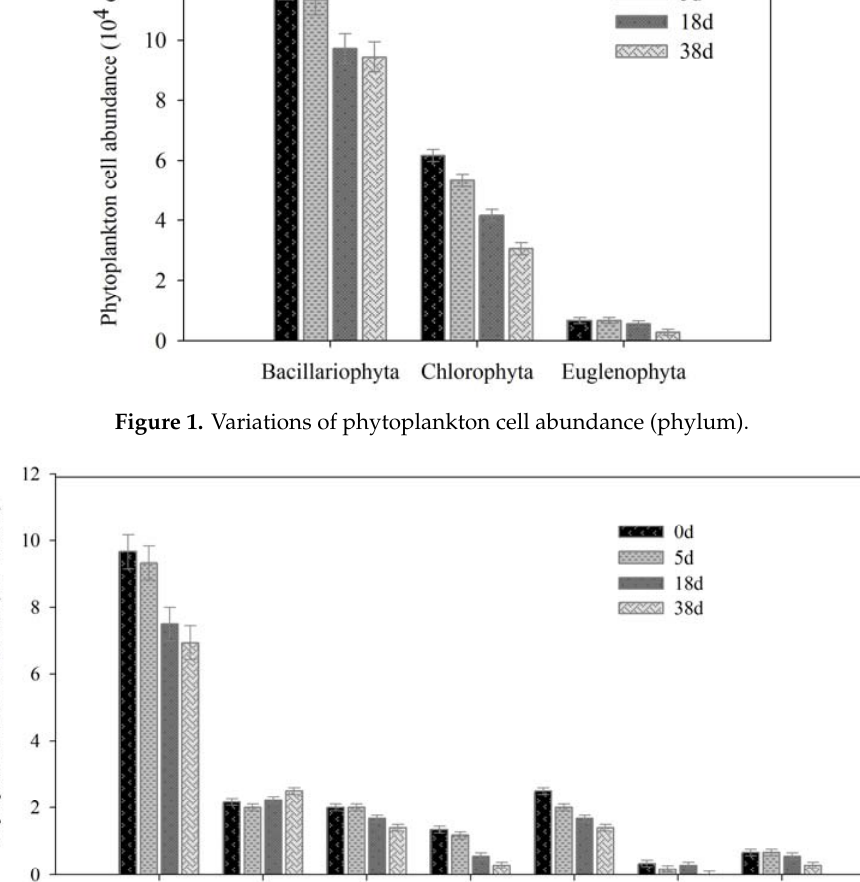
Figure 2. Variations of phytoplankton cell abundance (genera).